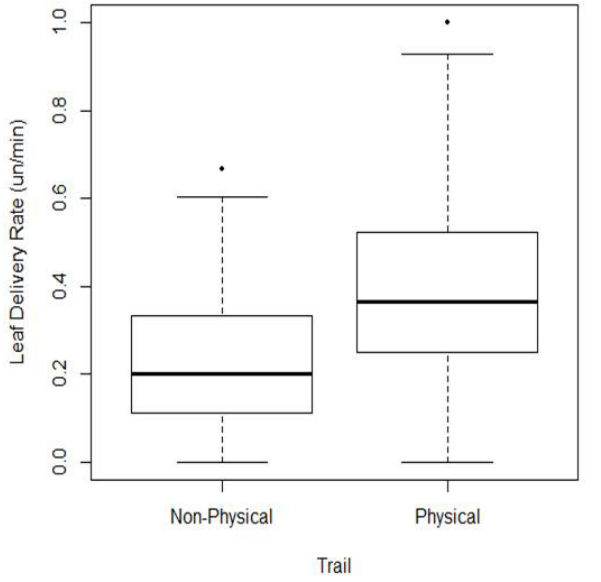
Fig 2. Relationship between leaf delivery rate and the two types of trails - physical and non-physical.